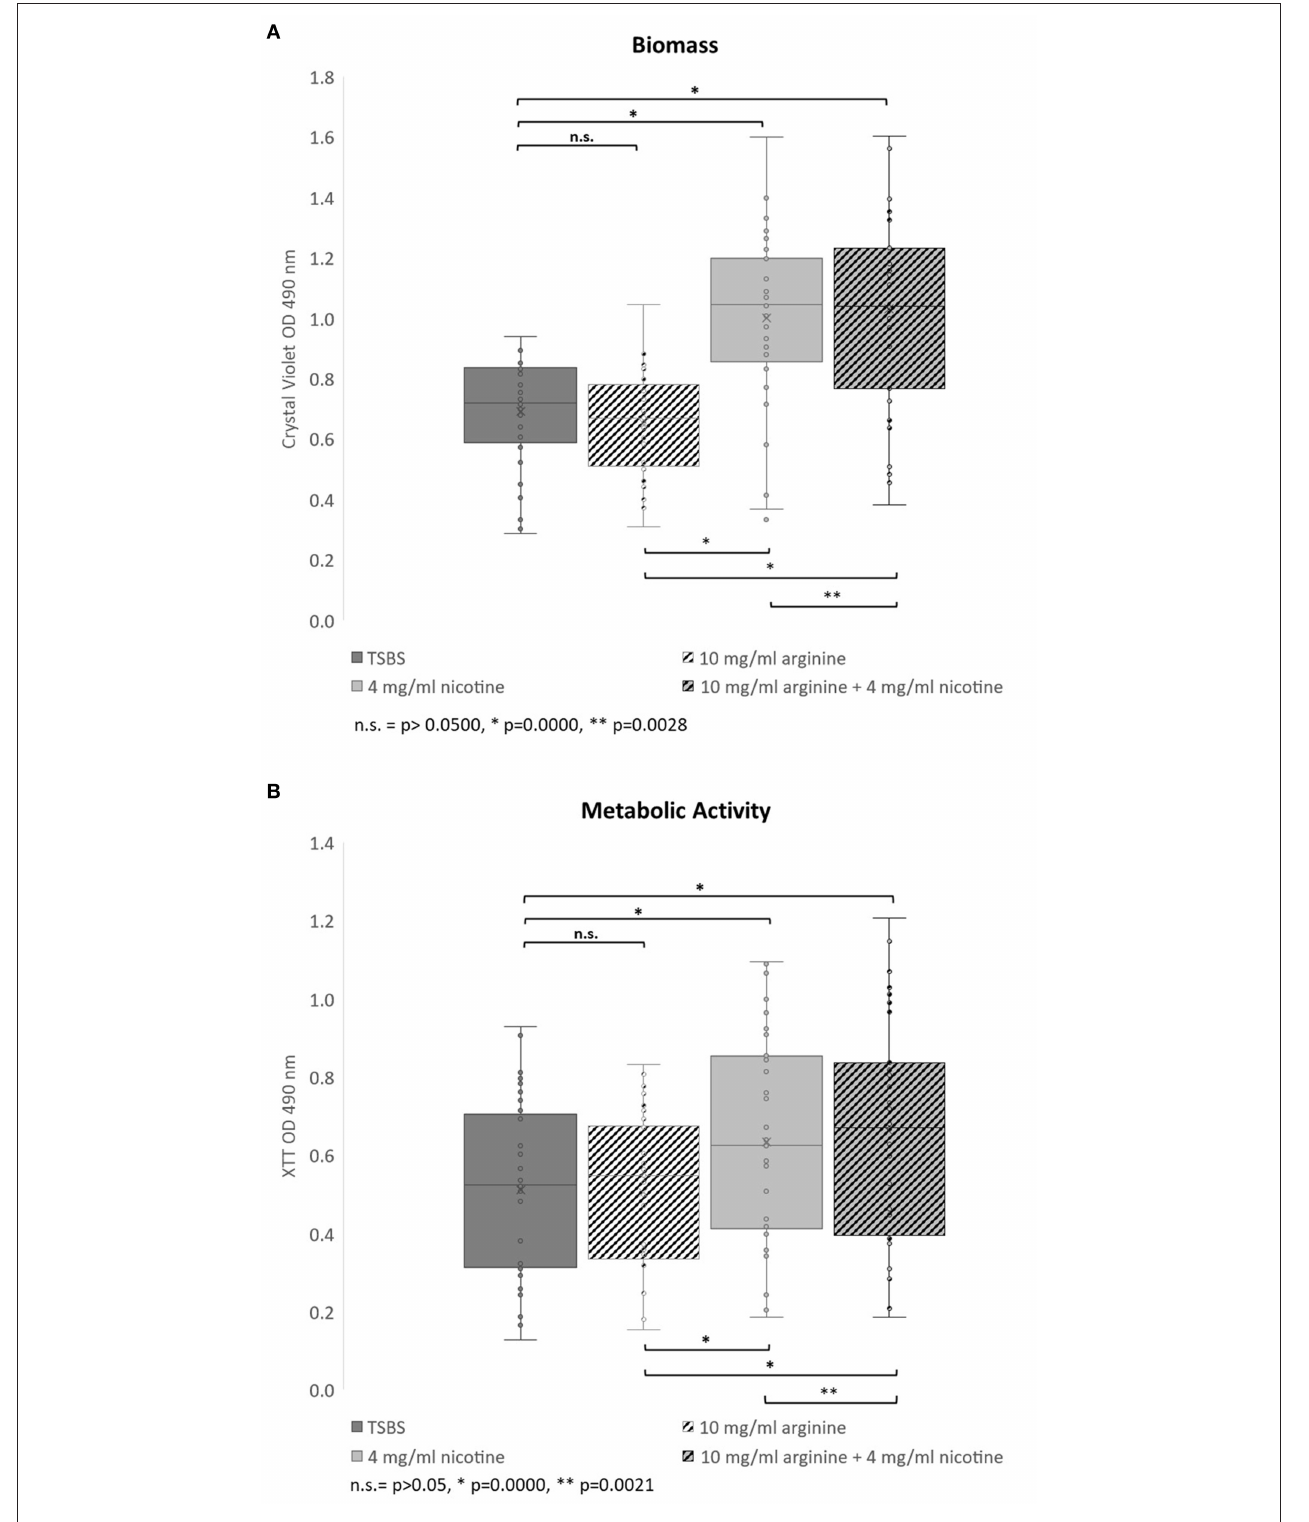
FIGURE 1 | Bar and whisker plots showing the separate and combined effects of arginine and nicotine on S. mutans 24h biofilm growth and metabolic activity. Individual biofilms from all 33 strains were grown for 24h in TSBS (dark gray), 10 mg/ml arginine (black and white diagonal), 4 mg/ml nicotine (light gray) and 10 mg/ml arginine plus 4 mg/ml nicotine (gray and black diagonal) and (A) stained with crystal violet to measure biomass or (B) tested for metabolic activity by the XTT assay. Statistical comparisons are shown in the horizontal bars above and below the plots.